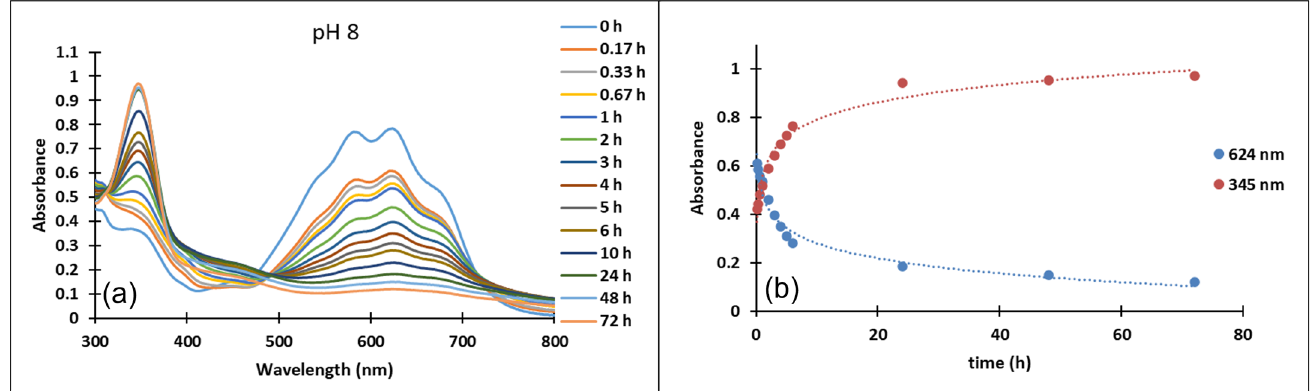
Figure 6. Absorption spectra of the species derived from compound 3 ( a ) at pH 8 in time ( b ) variation in time of the absorption maxima of the quinoidal base A λ = 624 nm and the cis or trans chalcones λ = 345 nm at pH 8.